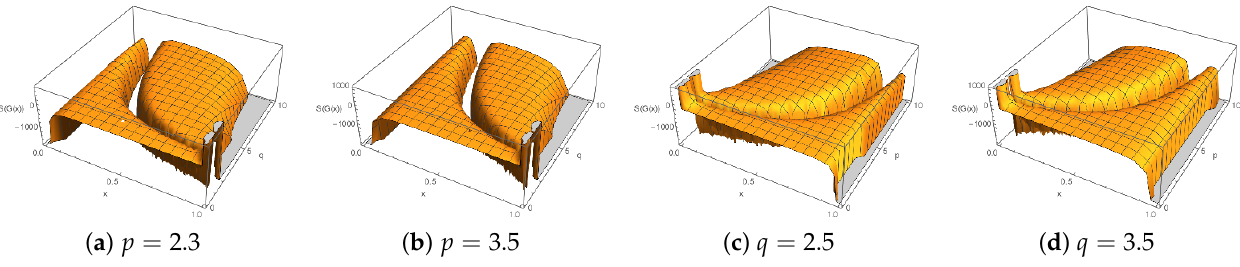
Figure 5. Schwarzian derivatives of r G p , q ,1,1 ( x ) = r x p − 1 ( 1 − x ) q − 1 .